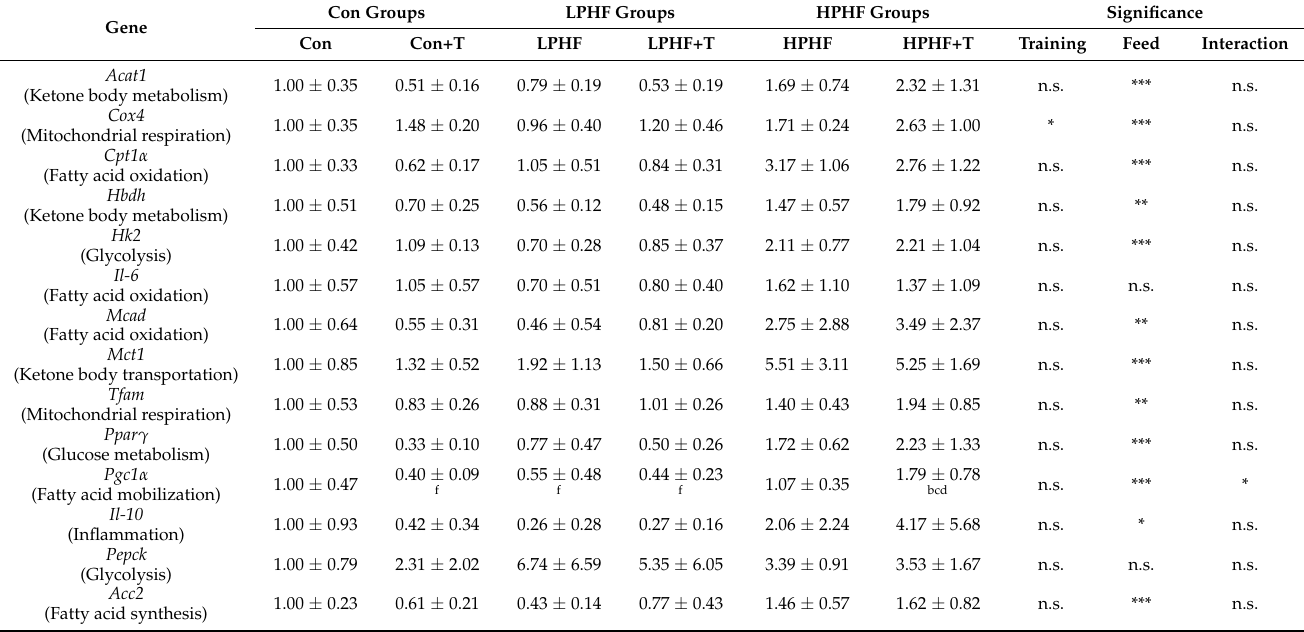
Table 8. Effects of LPHF, HPHF, and/or training on soleus muscle gene